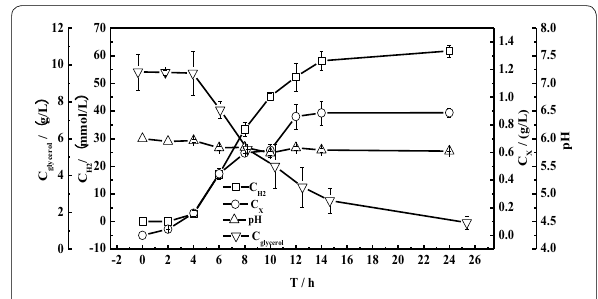
Fig. 3 The properties of biohydrogen production through glycerol anaerobic fermentation by EB-06 in batch